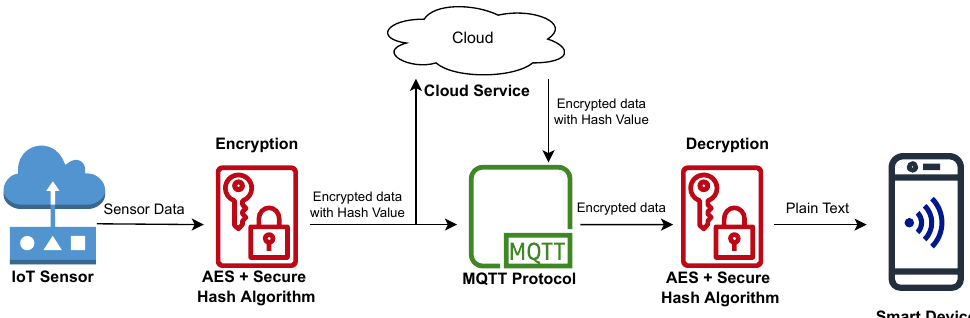
Figure 2. The Advanced Encryption Standard (AES) is used to safeguard data received by a smart- phone from IoT